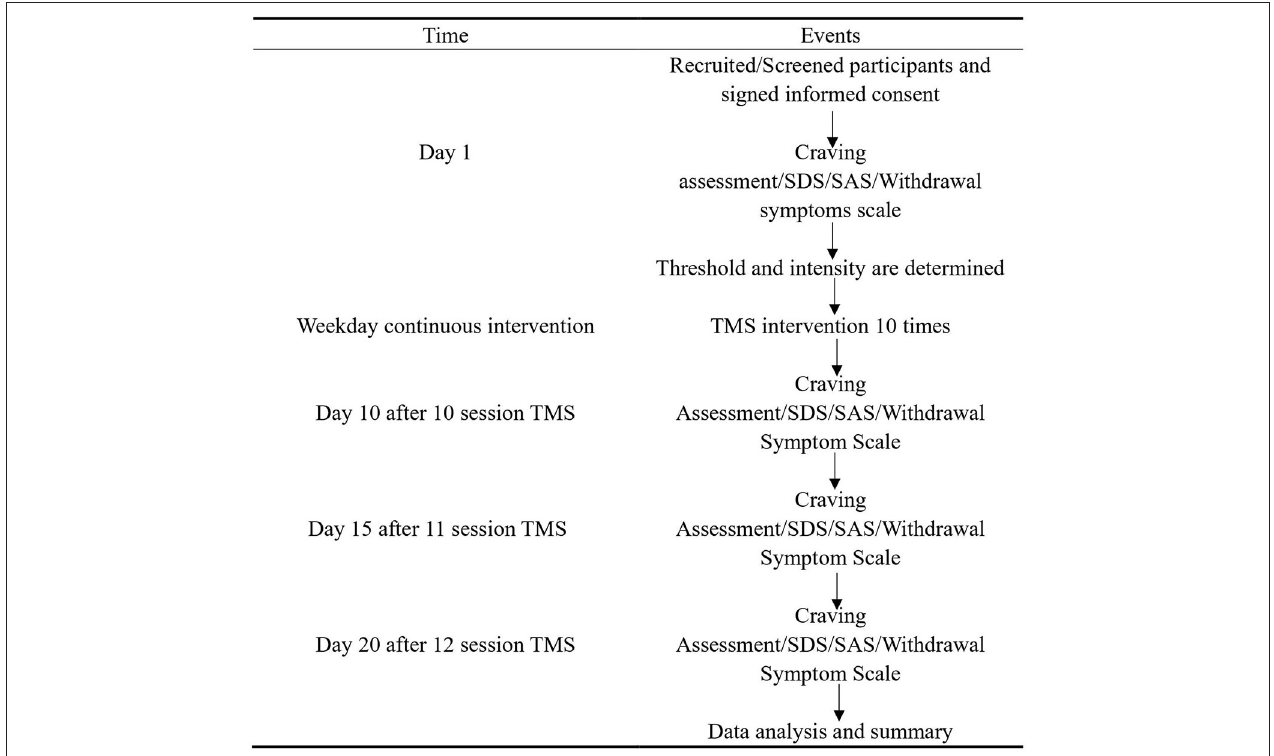
FIGURE 1 | Flowchart of experimental